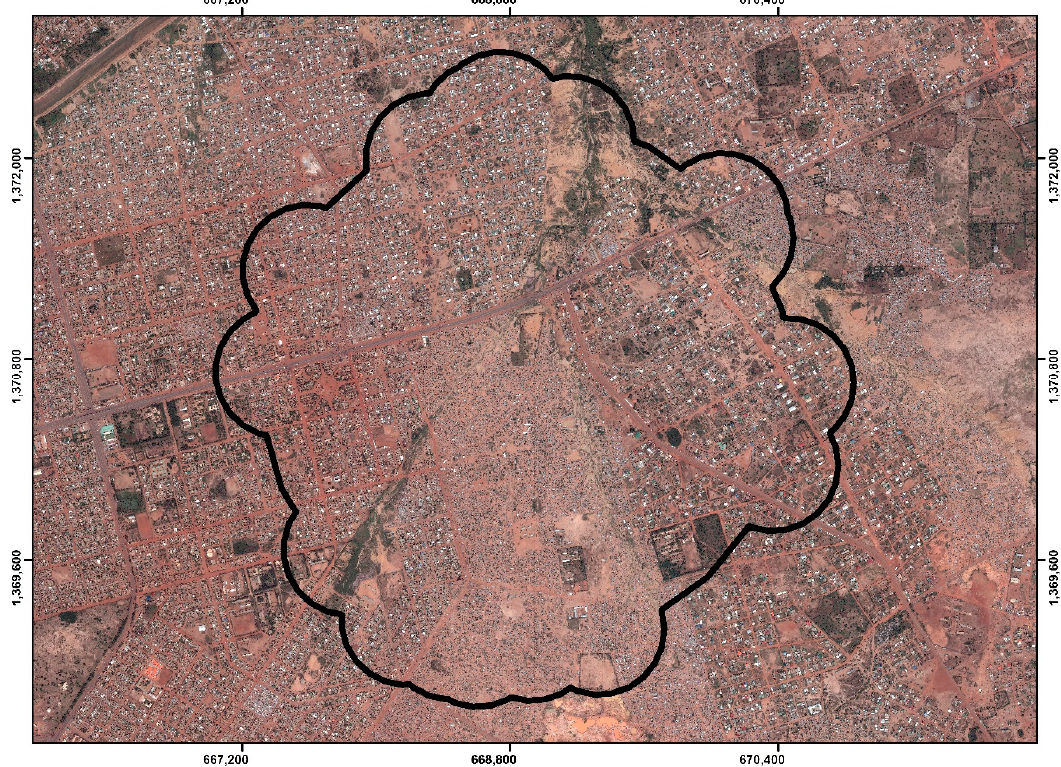
Figure 2. Subset of the WorldView-3 imagery (~10 km 2 ) where the RG’s TP was optimized f or use in the whole image. The selected area contains a distribution of land cover classes representative of the whole study